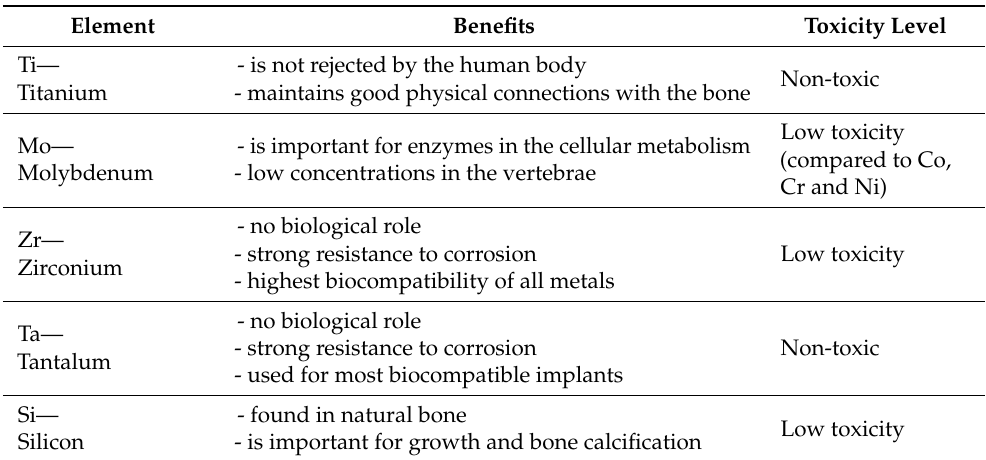
Table 1. Benefits of the elements in the human body from Ti-Mo-Zr-Ta-Si system.